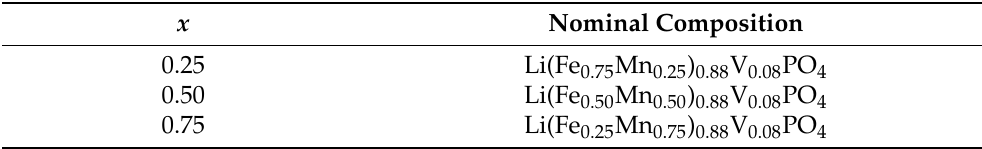
Table 1. Nominal compositions of the samples under